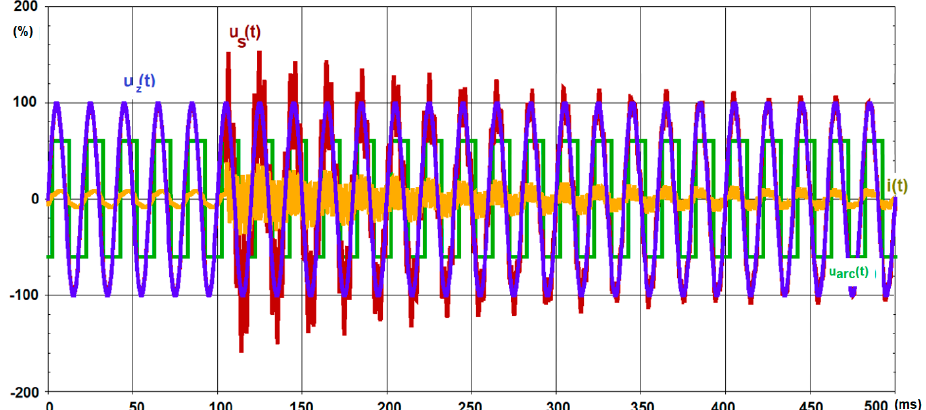
Figure 26. Waveforms of supply voltage u z (t), voltage on steel busbars u S (t), as well as voltage u arc (t) and arc current i (t), switching on capacitor banks (networks with high short-circuit power).